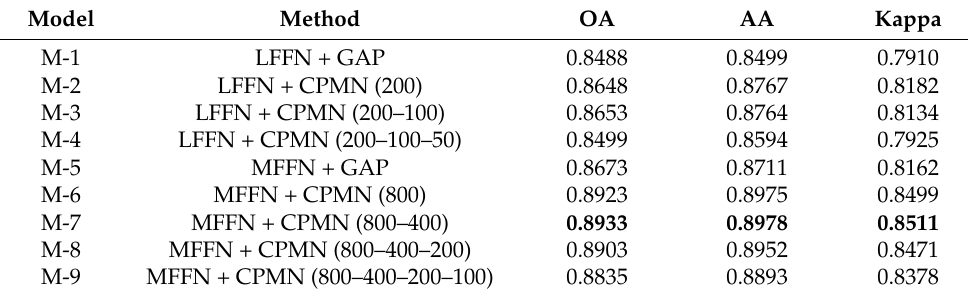
Table 4. Classification accuracy comparison with different